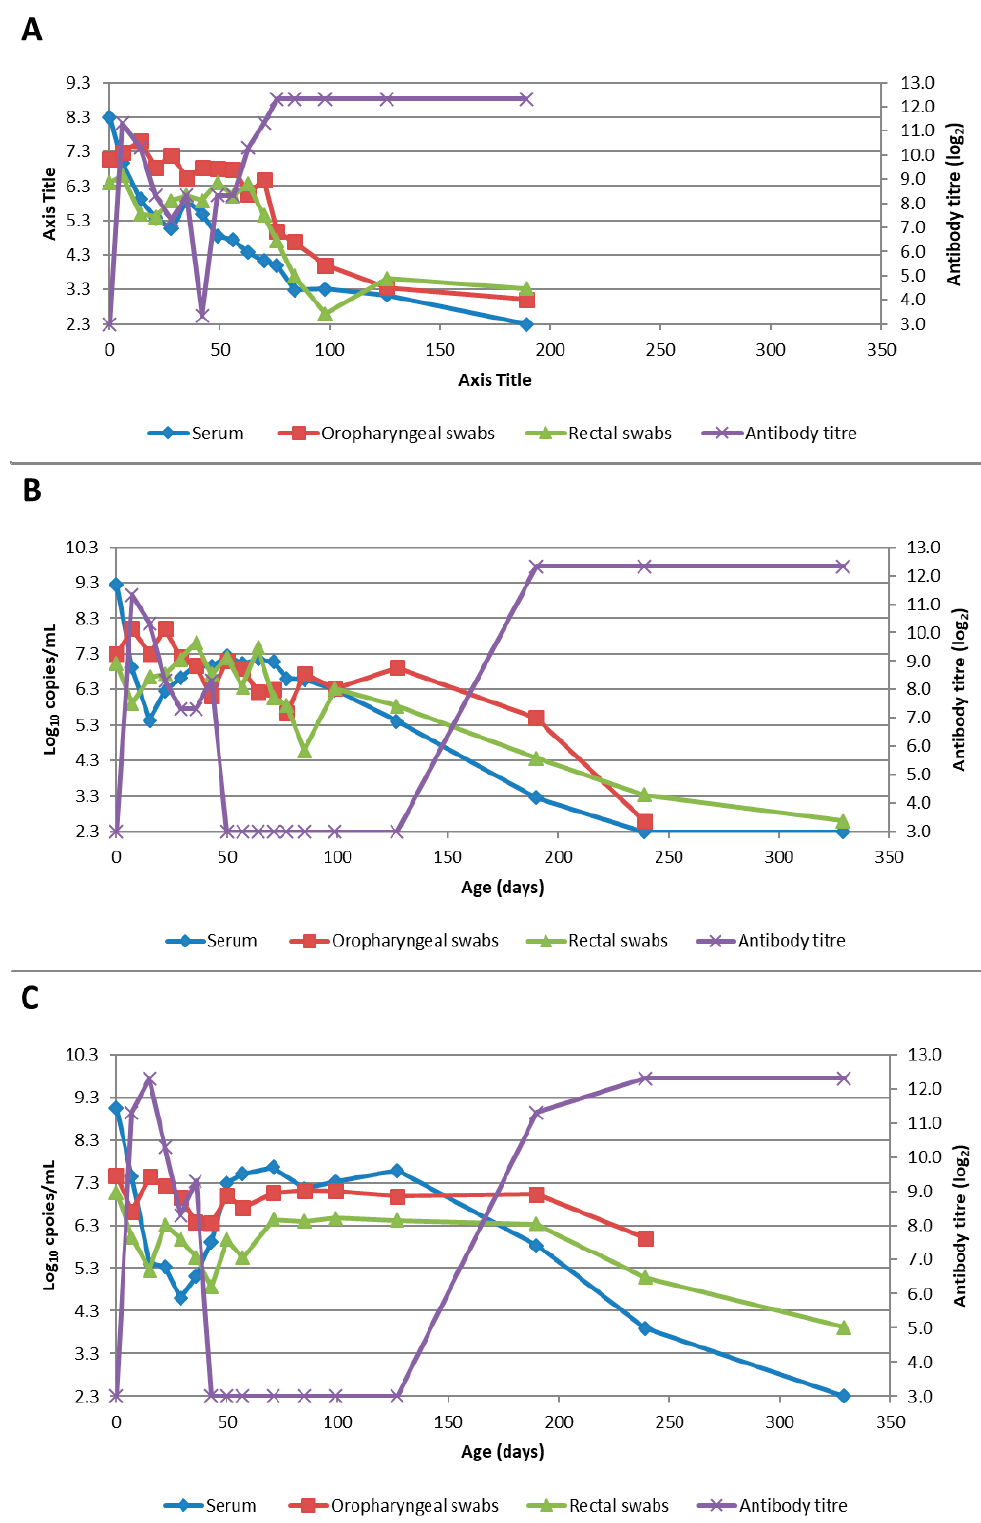
Figure 6. Quantity of Bungowannah virus detected in serum, oropharyngeal and rectal swabs, and antibody titre against Bungowannah virus detected in: ( A ) 10-01 from birth to 189 days of age; ( B ) 8-01 (D55 Ab − ve) from birth to 329 days of age; ( C ) 8-05 (D55 Ab − ve) from birth to 329 days of age.